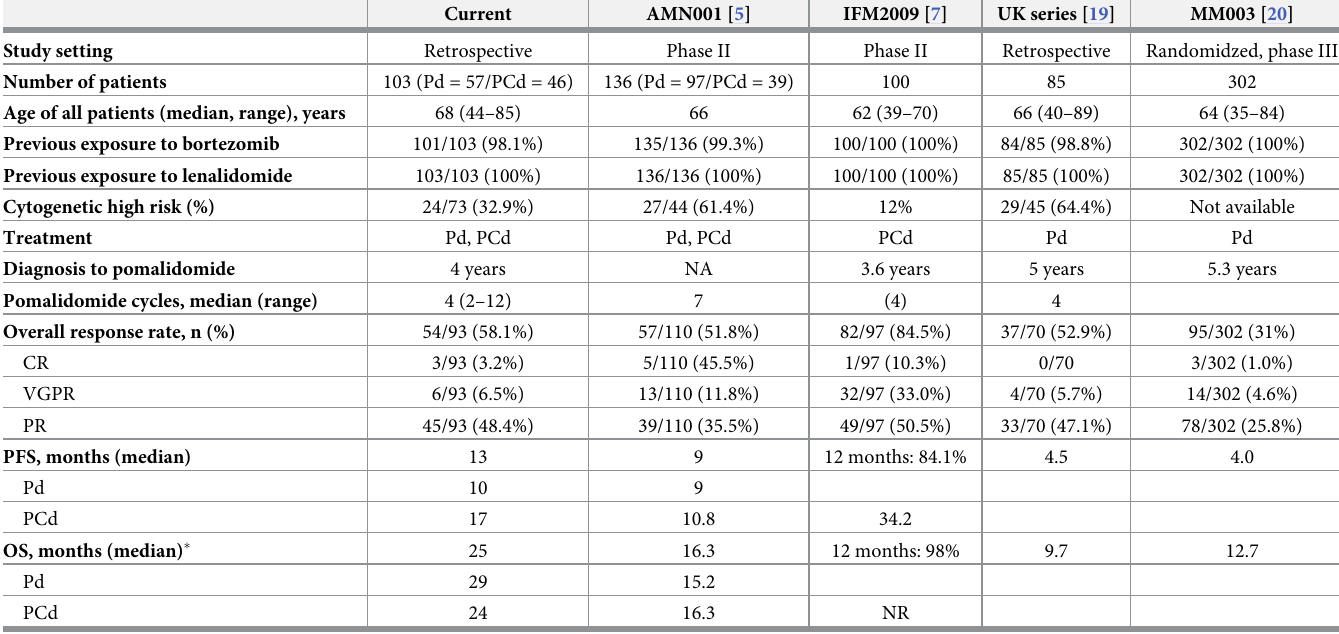
Table 6. The comparison with previous